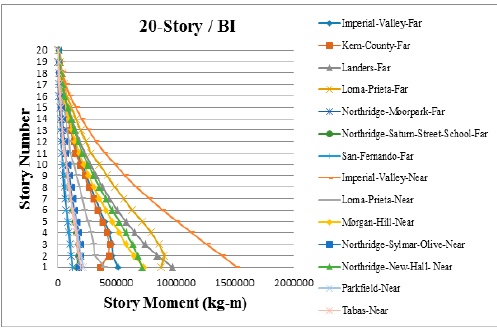
Figure A24. Peak story moments for 20-story base-isolated building.